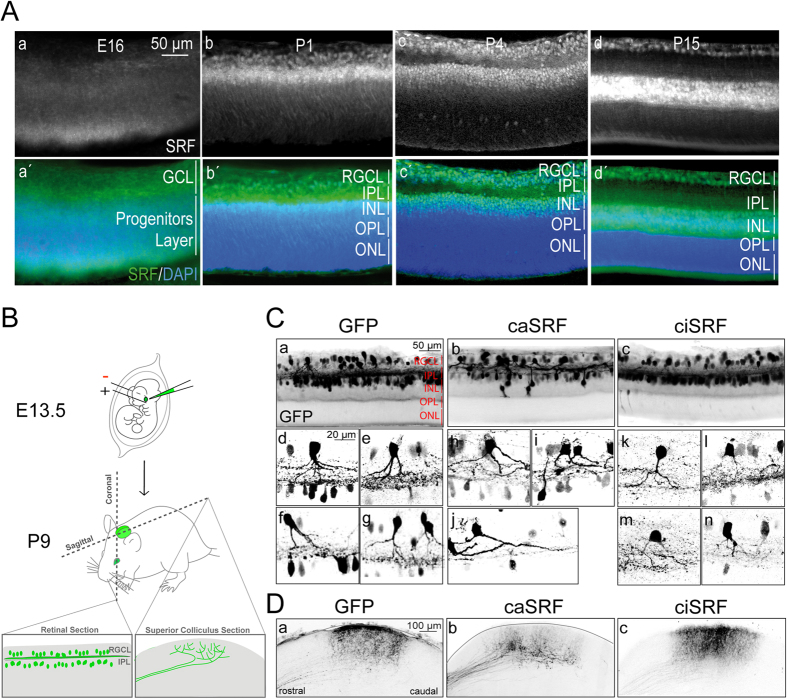
Altered SRF activity also causes growth defects in the developing visual system.(A) Expression pattern of SRF in the developing retina at different ages: E16, P1, P4 and P15. (a–d) Immunostaining of SRF in retinal sections from developing or postnatal mice. SRF expression is upregulated after birth. At P4, SRF expression is visible in the retinal ganglion cells and the inner nuclear layers. Two weeks after birth, SRF is still expressed in the RGC layer and strongly expressed in the INL. (a′–d′) Same sections counterstained with DAPI to better visualize the different retinal layers. RGCL, retinal ganglion cells layer; IPL, inner plexiform layer; INL, inner nuclear layer; OPL, outer plexiform layer; ONL, outer nuclear layer. (B) Scheme of the experiment. (C) SRF modulates retinal dendrites arborization. (a–c) Retinal sections from P9 mice electroporated at E13.5 with plasmids encoding for GFP, caSRF and ciSRF. (d–n) Higher magnification images of retinal neurons from GFP (d–g), caSRF (h–j), or ciSRF (k–n) conditions. (D) SRF controls axon branching at the superior colliculus (SC). Sagittal sections through the SC of P9 in the three conditions: GFP (a), caSRF (b) and ciSRF (c).